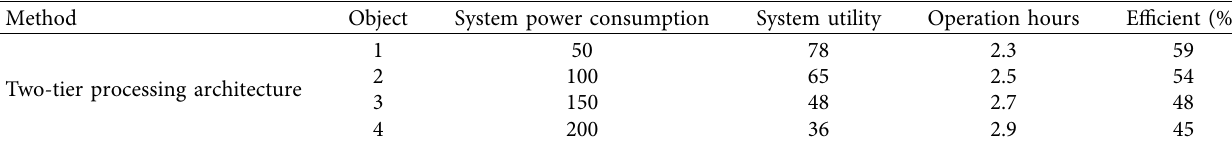
Table 3: System utility table for two-tier processing architecture with the same system power consumption. Method